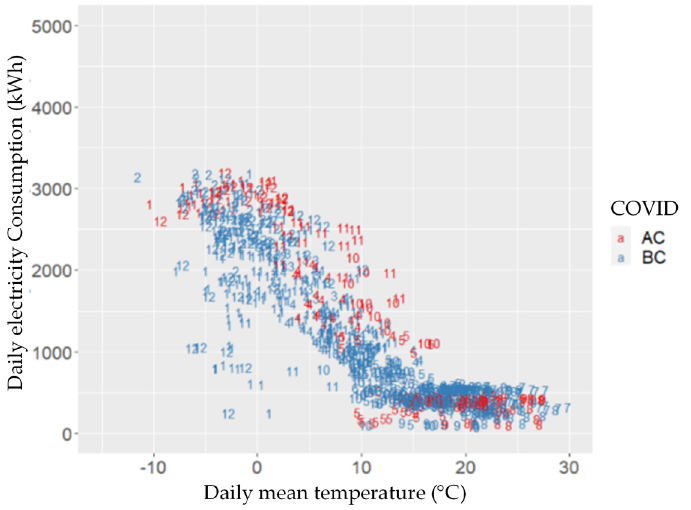
Figure 12. Relationship between daily energy consumption and outdoor temperature at Elementary School E.